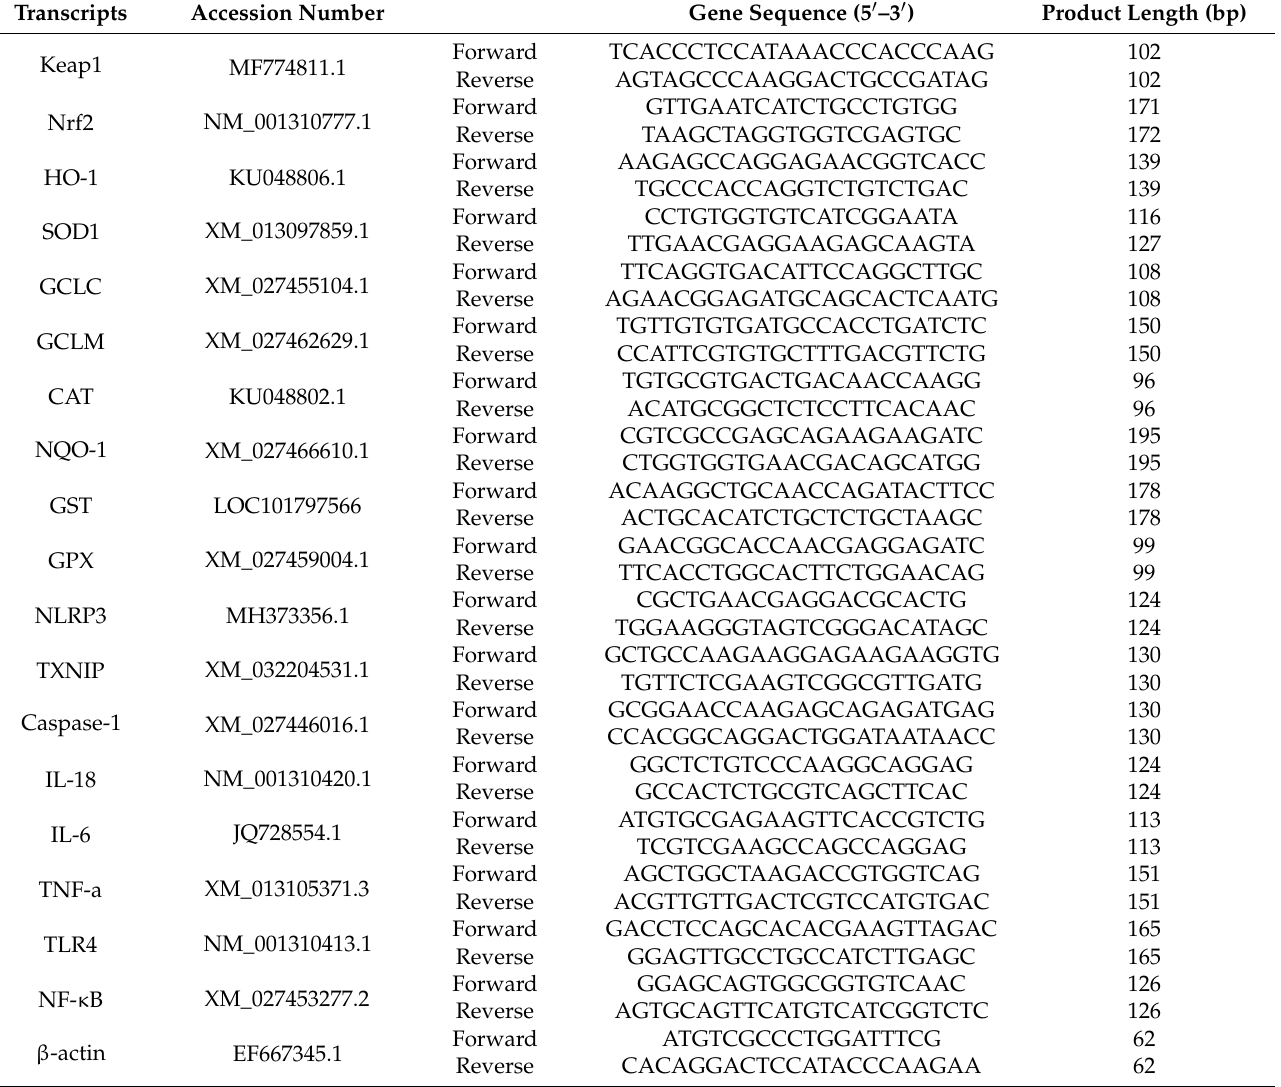
Table 3. Sequences, product sizes and TM values of primers for target